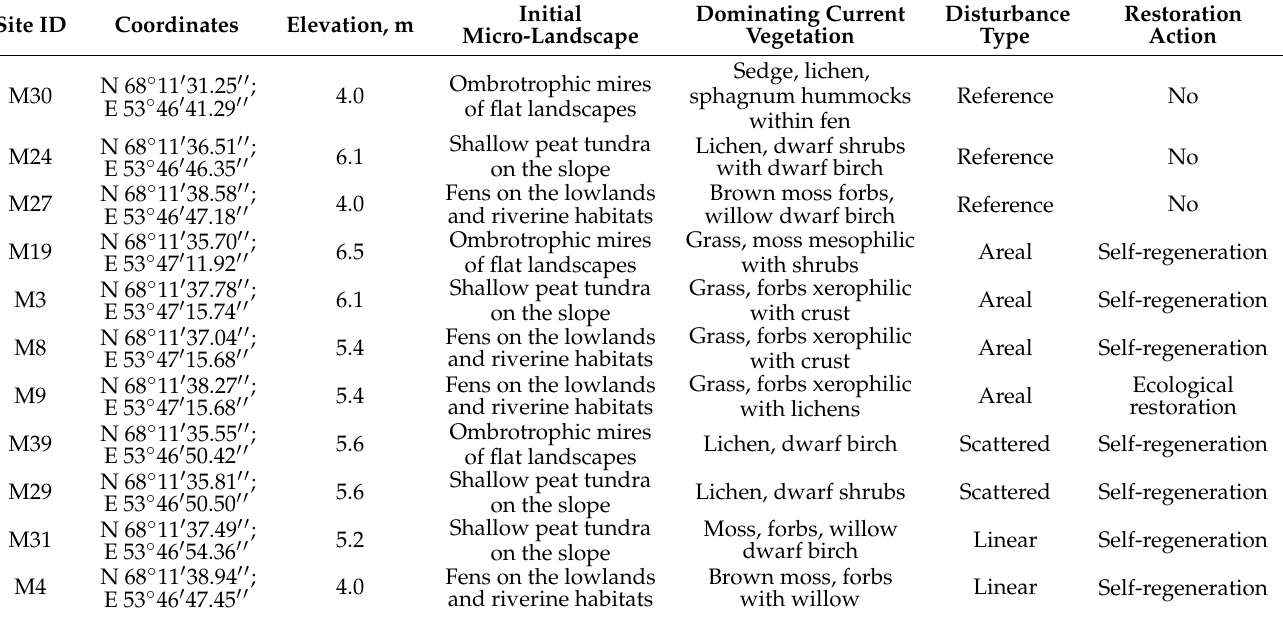
Table 1. General characteristic of the sampling